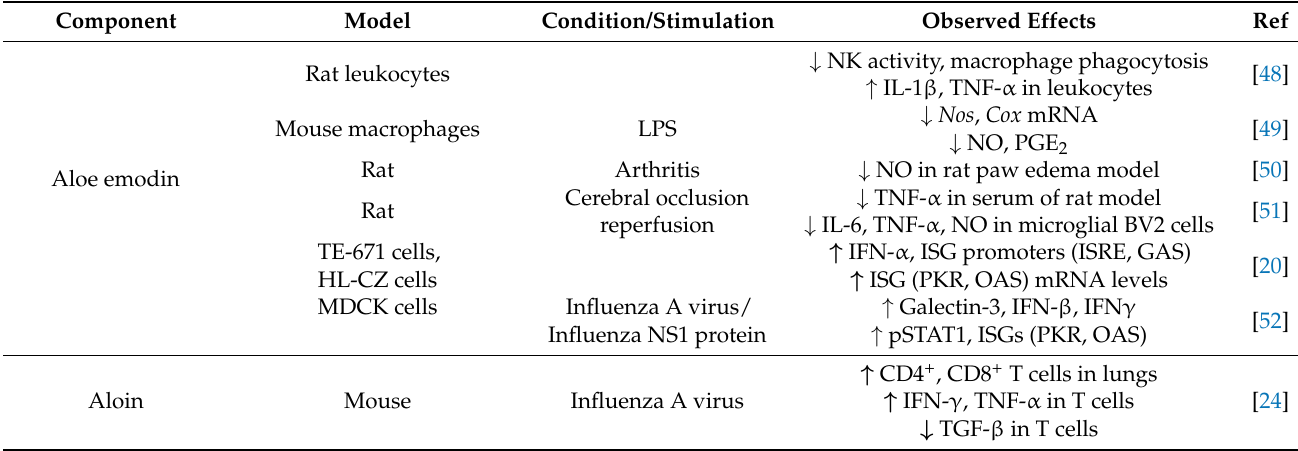
Table 3. Immunomodulatory effects of Aloe vera